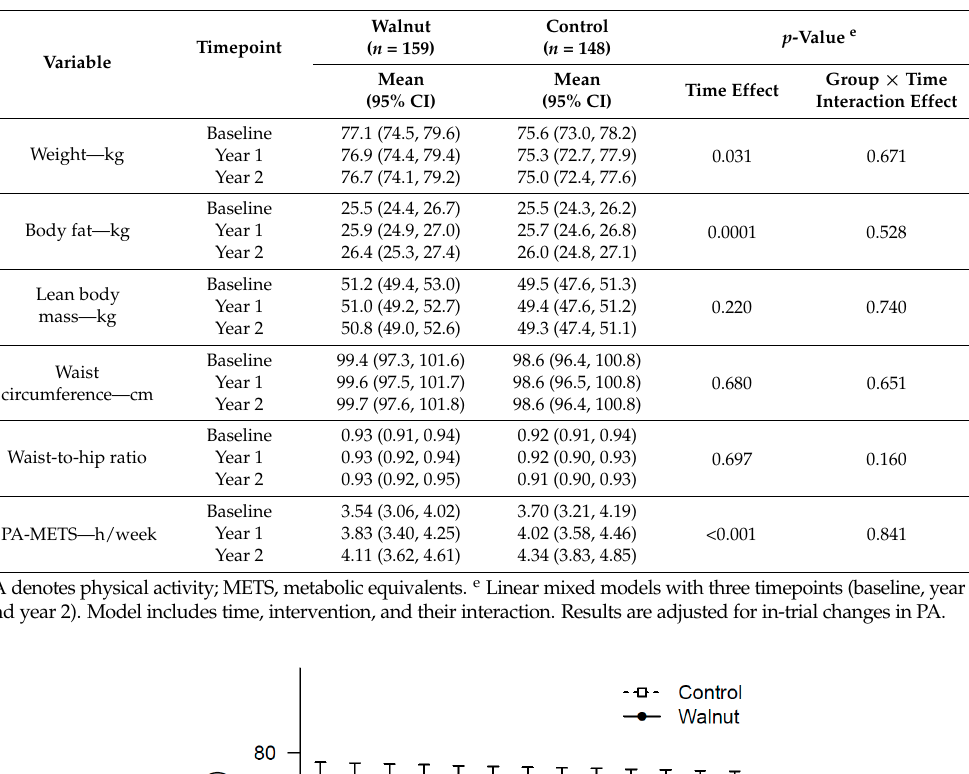
Table 3. Adiposity and physical activity during the 2-year follow-up by intervention group.